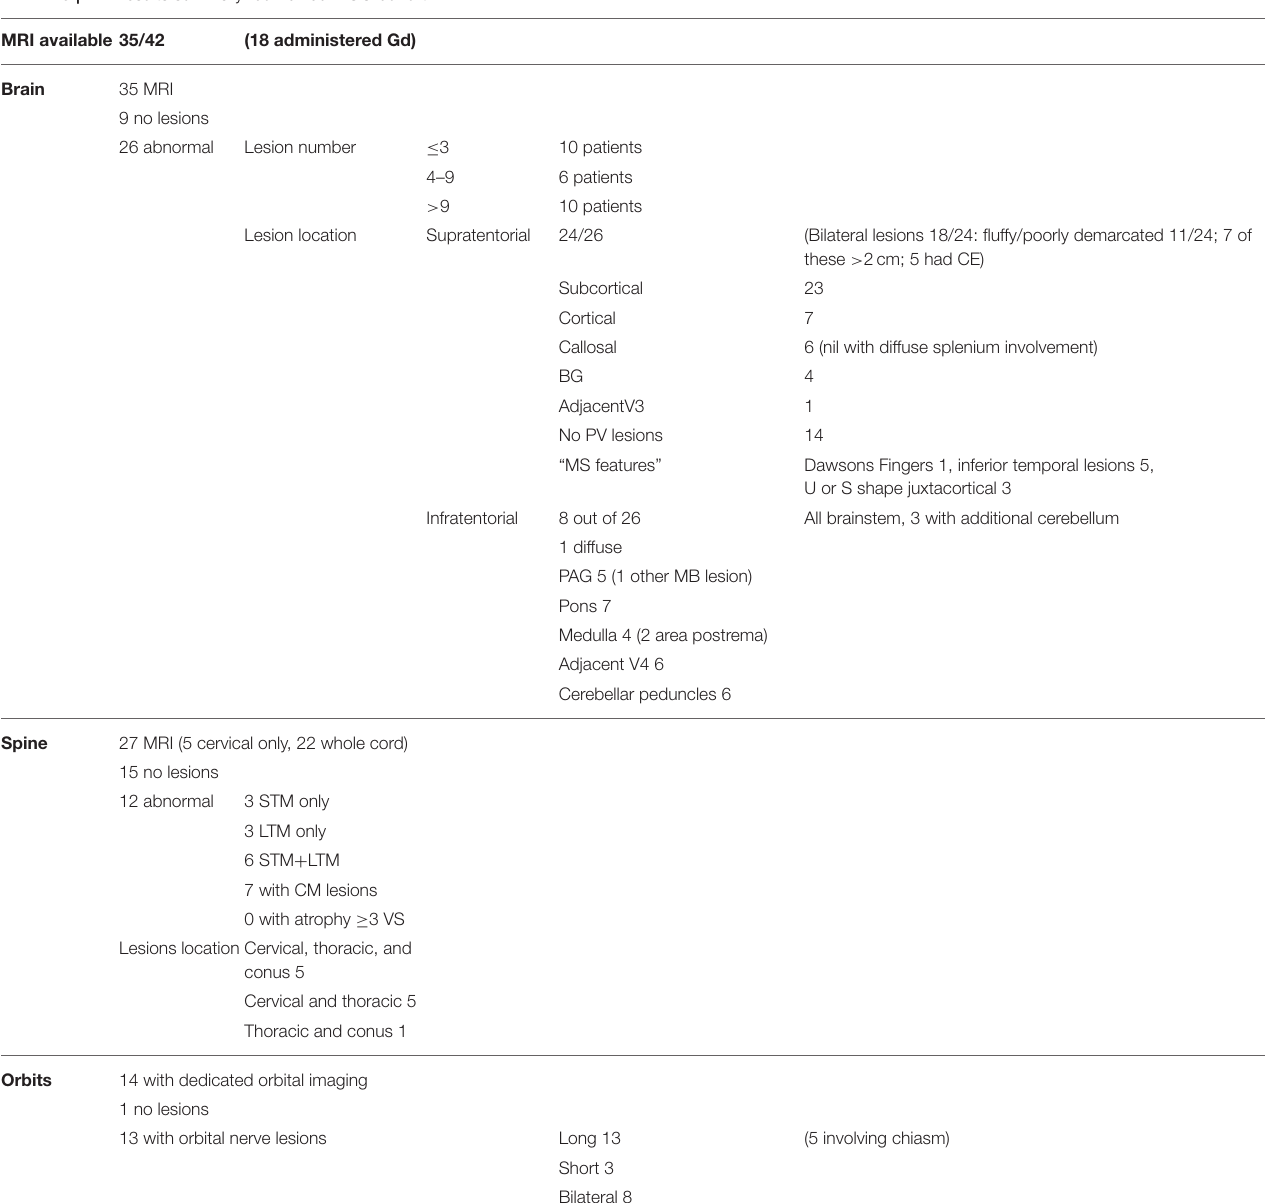
TABLE 3 | MRI results summary: combined MOG cohort. MRI available